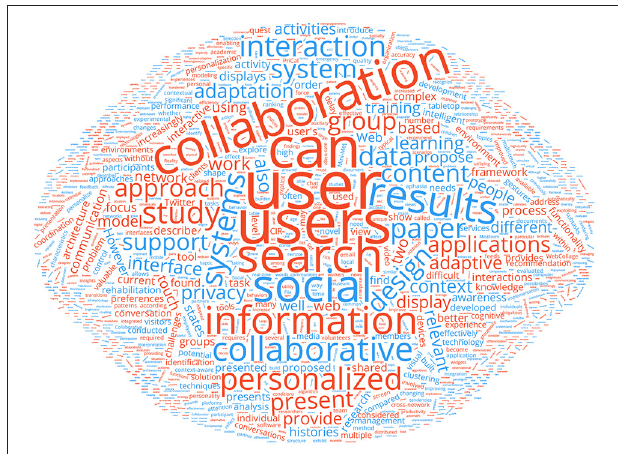
FIGURE 2 | Word cloud (generated by wortwolken.com) depicting the words most frequently used in the papers’